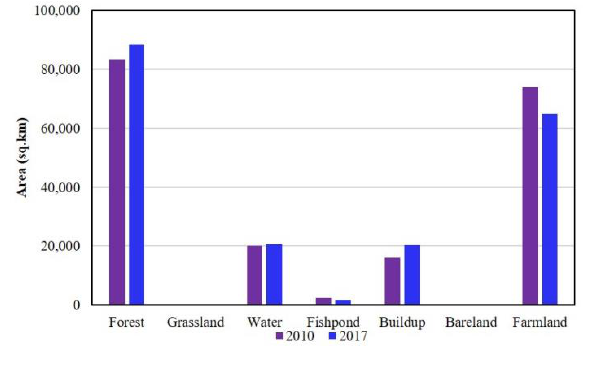
Figure 3. Land use land cover trend in Guangdong, Hong, and Macao from 2010 to 2017.